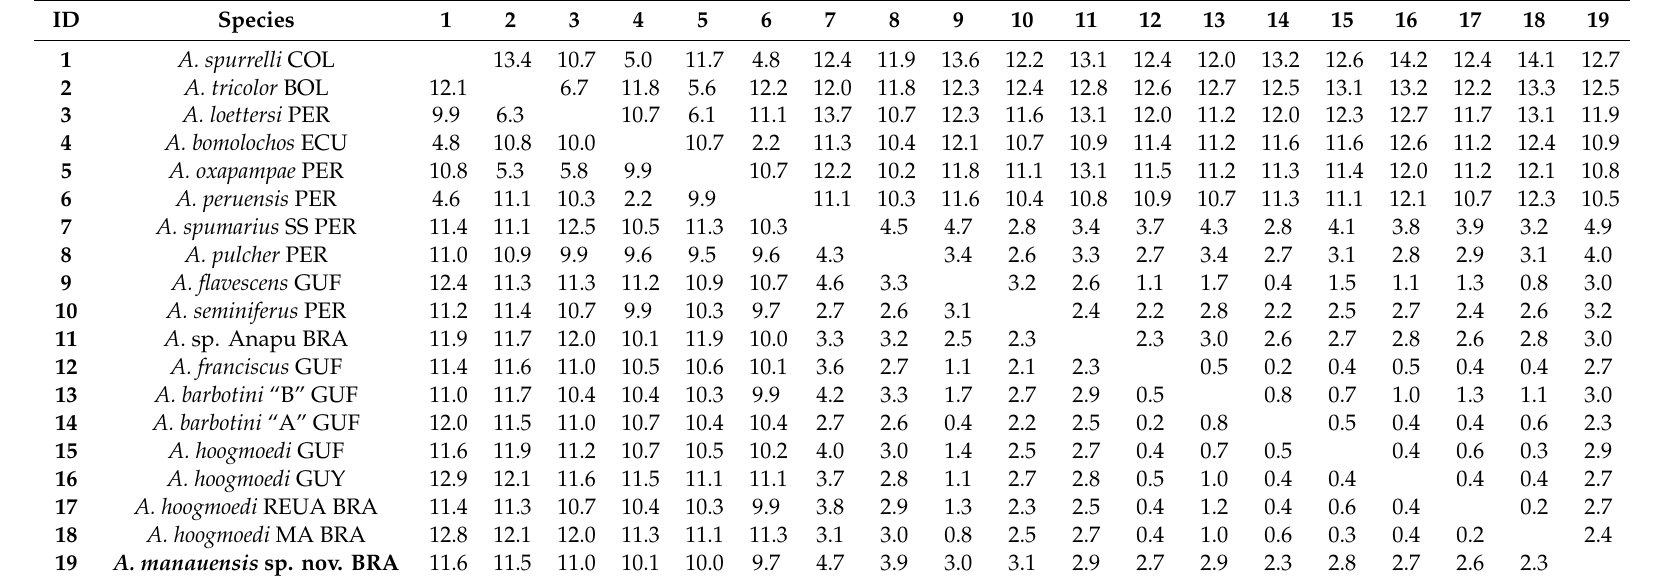
Table 2. Uncorrected p–distances (upper diagonal) and Kimura 2-Parameter (lower diagonal) between Atelopus manauensis sp. nov. and species of the Amazonian–Guianan clade and of the Andean–Choc ó –Central American clade. Genetic distances were calculated using 16S rRNA sequences and are presented as percentages. Abbreviations: (COL) Colombia, (BOL) Bolivia, (PER) Peru, (ECU) Ecuador, (SS) sensu stricto, (GUF) French Guiana, (BRA) Brazil, (GUY)